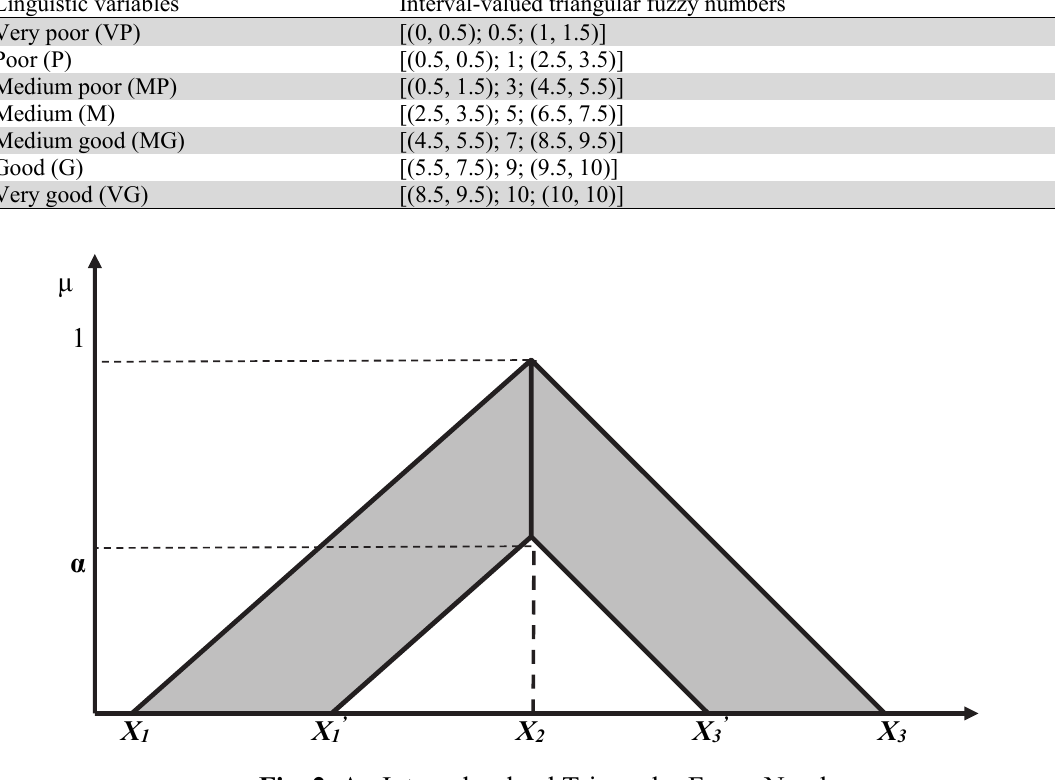
Fig. 2. An Interval-valued Triangular Fuzzy